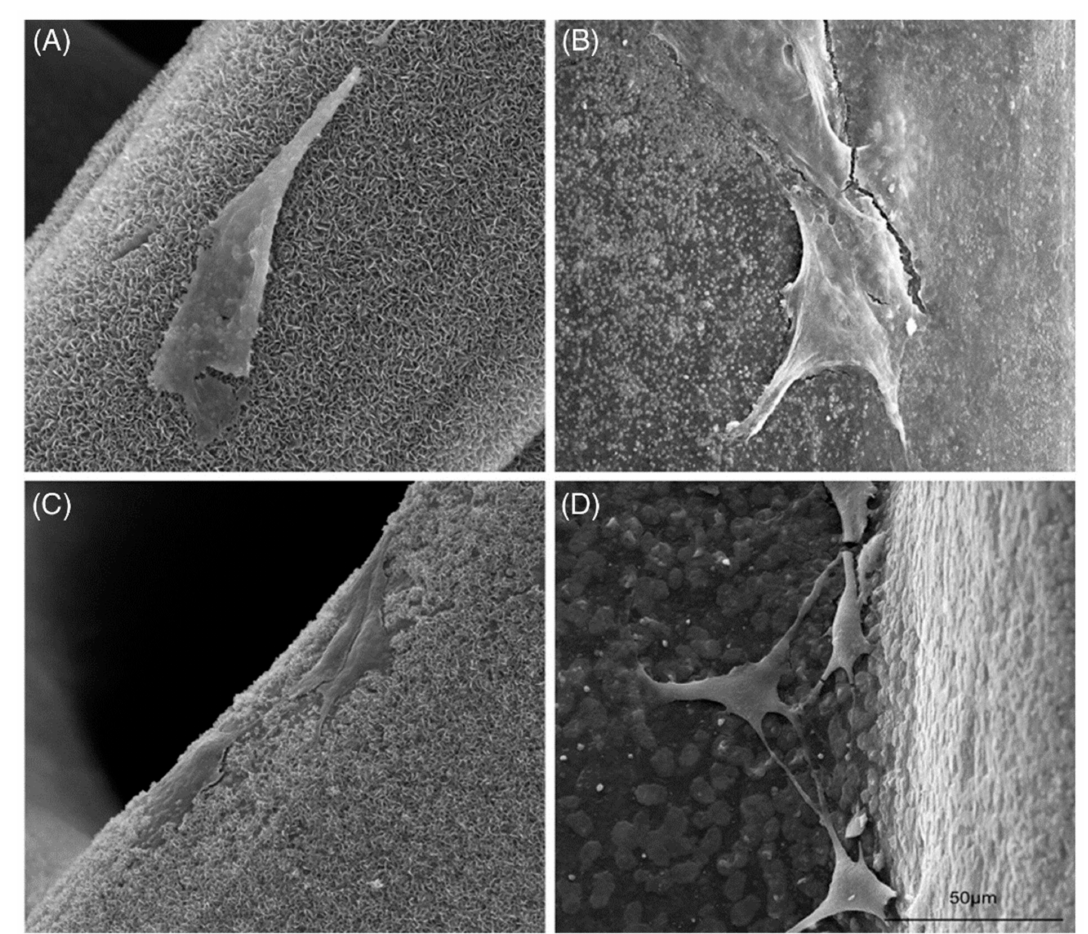
Figure 5. SEM images of adhered cells on ( A ) PCL, ( B ) 30 wt.% pearl/PCL, ( C ) 50 wt.% pearl/PCL ( D ) 80 wt.% pearl/PCL scaffolds, and ( D ) scaffolds after cultured for 7 days (scale bar: 50 µ m). Reproduced from